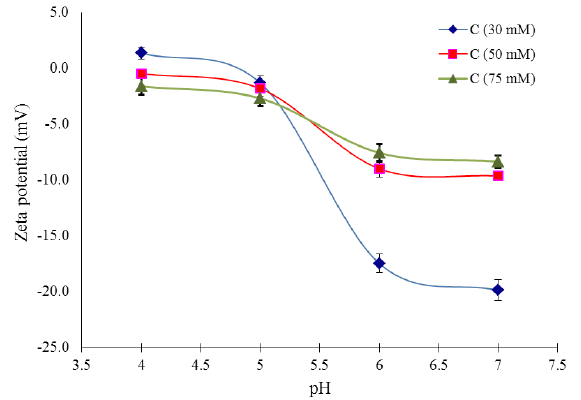
Figure 3: Plots of the zeta potential values obtained for different salt concentration prepared at different pH values.